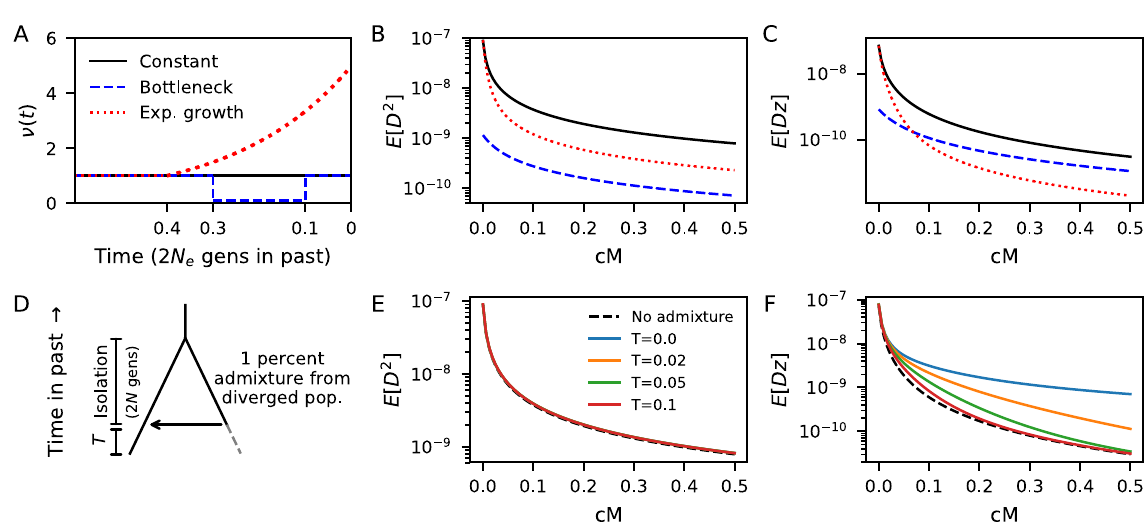
Fig 2. LD curves are sensitive to demography. Demographic histories shown in (A) affect statistics in the Hill-Robertson system and their dependance on recombination distance (B-C). Both the amplitude and shape of the LD curves differ between demographic models for (B) E ½ D 2 � and (C) E ½ Dz � ¼ E ½ D ð 1 (cid:0) 2 p Þð 1 (cid:0) 2 q Þ� . (D) To illustrate the effect of admixture on LD curves, we consider two populations in isolation for 2 N generations, followed by an admixture event where the focal population receives 1% of lineages from the diverged population. (E) E ½ D 2 � curves are largely unaffected by this low level of admixture. (F) However, E ½ Dz � is immediately and strongly elevated following admixture, and remains significantly elevated for prolonged time T (in units of 2 N generations) since the admixture event.